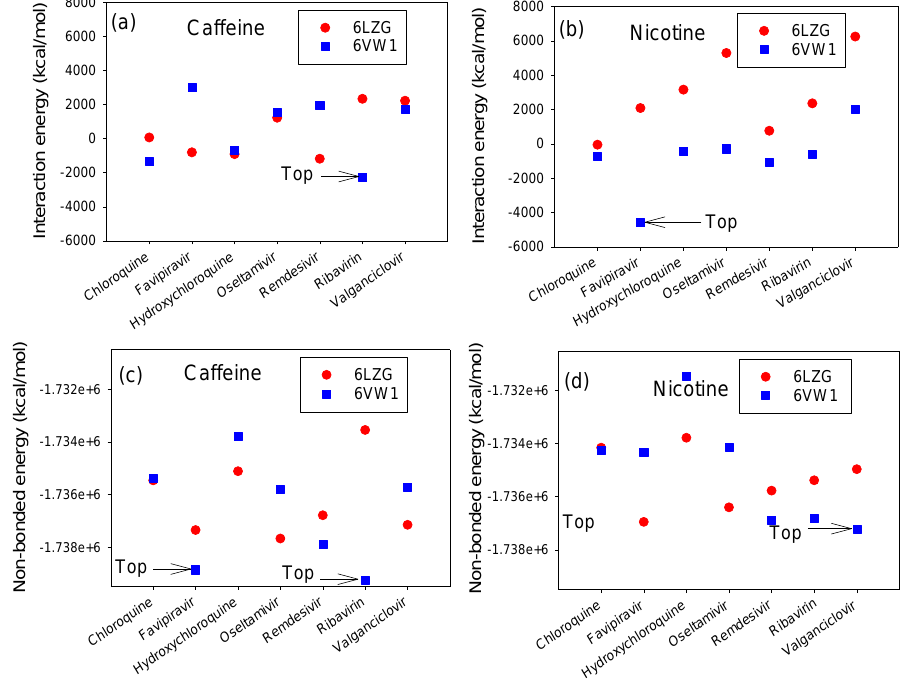
Figure 6. The interaction and non-bonded energies for drug and caffeine/nicotine structures with 6VW1 (RBD-ACE2) and 6LZG (CTD-ACE2). (a), (b) The interaction energies caffeine and nicotine, (c) and (d) the non-bonded energies caffeine and nicotine, respectively.